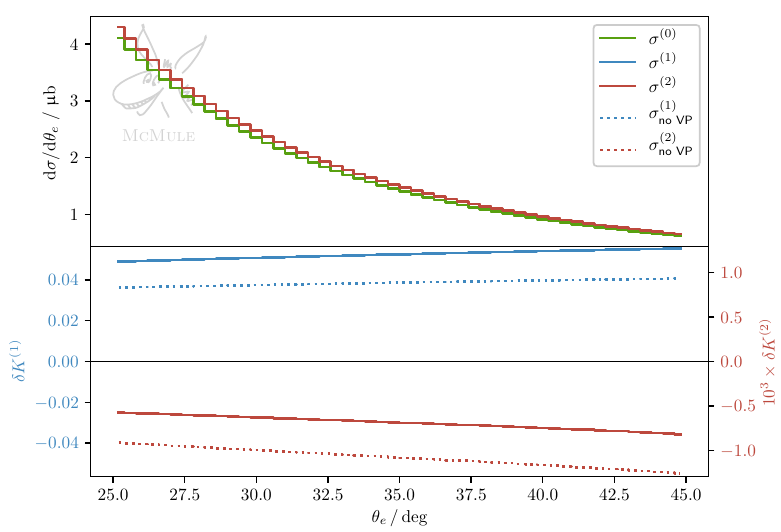
for a P2 setting at LO (green) and NNLO e